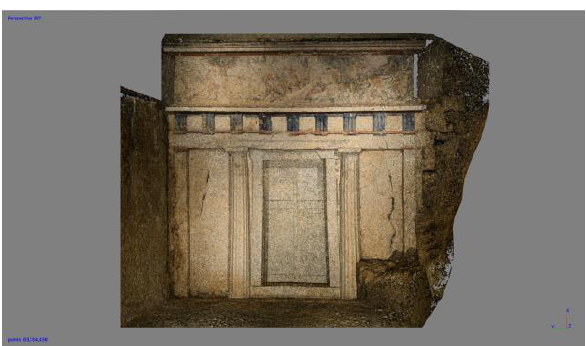
Figure 10. The Tomb of Alexander IV. Cloud of points.